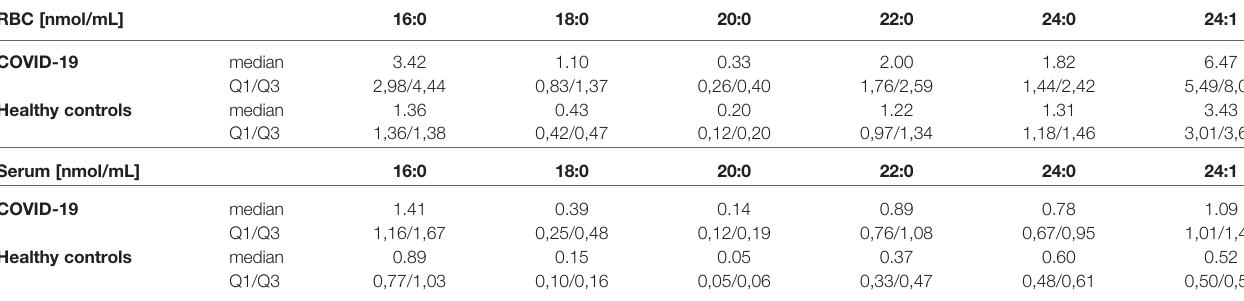
TABLE 3 | Comparing concentration of ceramides differing in chain length of acylated fatty acid 16:0 to 24:1. RBC [nmol/mL]